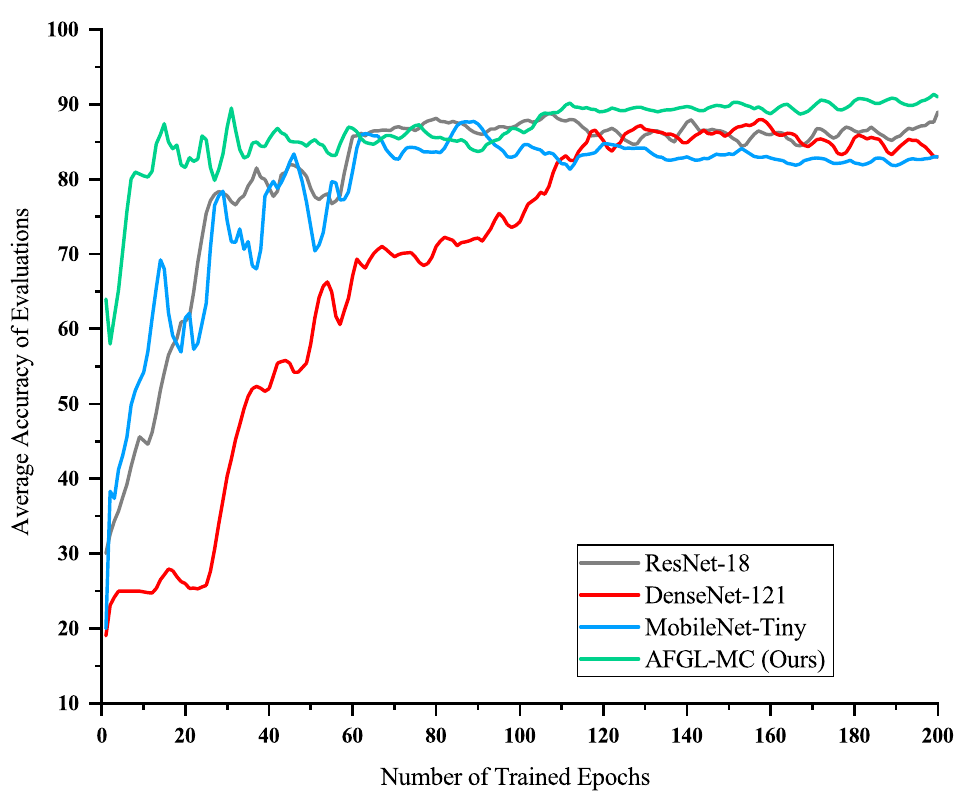
Figure 8. The evaluation results between accuracy and the saved trained models.